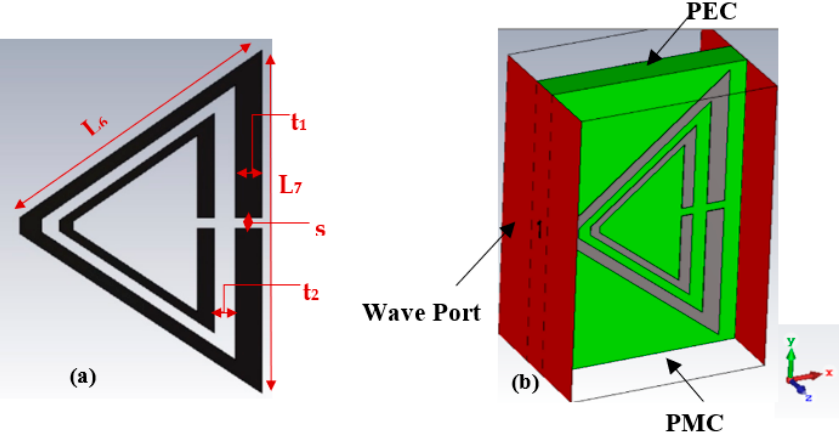
Figure 1. Geometry of proposed dual-band compact antenna: ( a ) front view, ( b ) back view.